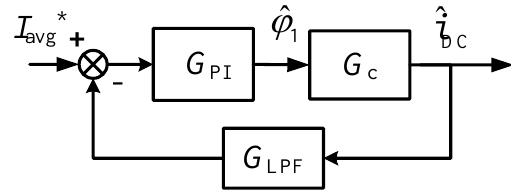
Figure 11. Control loop for the purpose of I avg control.